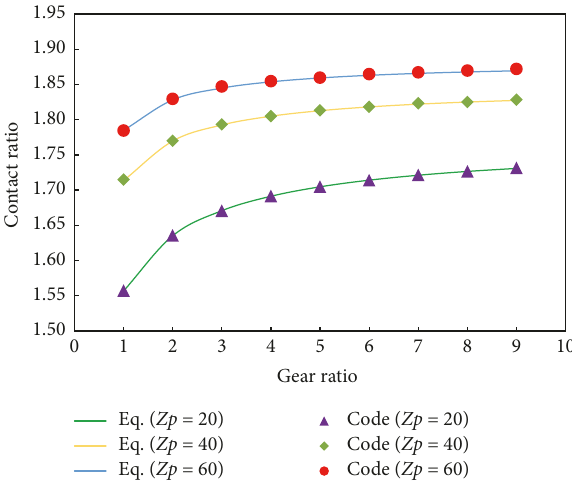
Figure 5: Contact ratio with respect to the gear